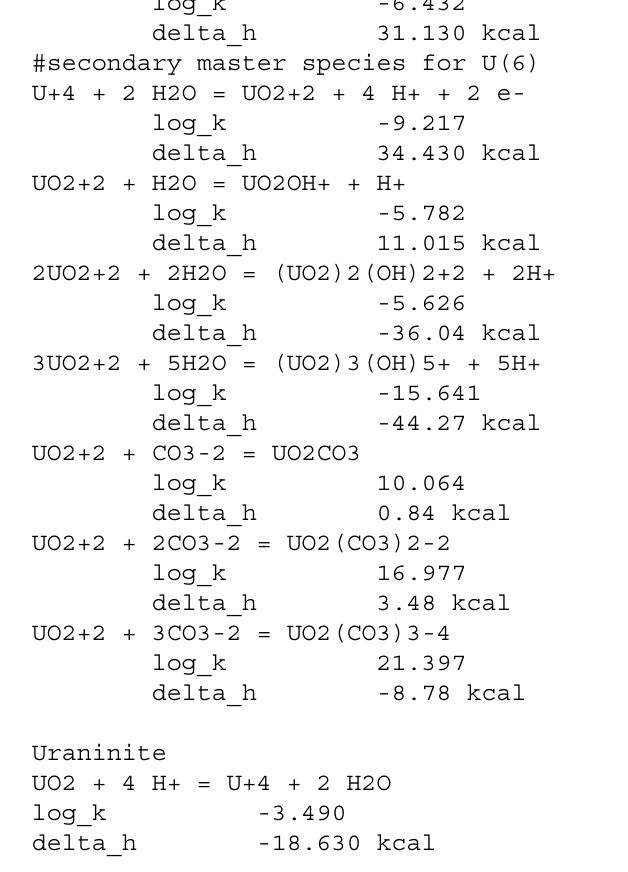
Table 10. Input file for example